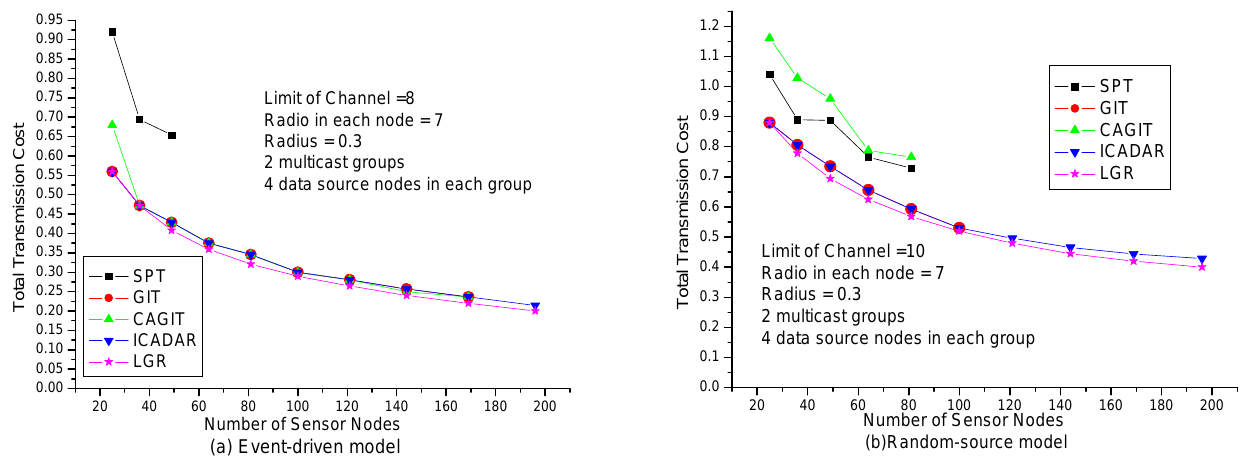
Figure 10. Performance comparison with respect to the network